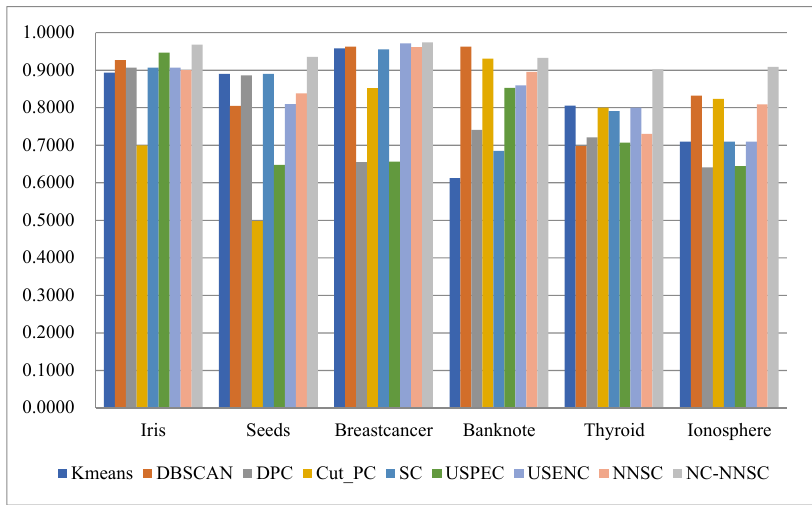
Figure 15. The Accuracy index of different clustering algorithms in six real-world datasets.